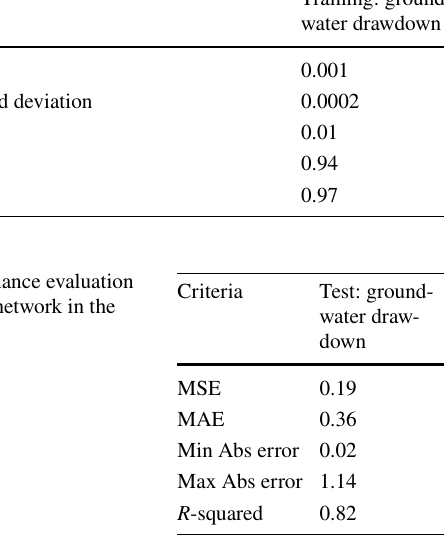
Table 3 Performance evaluation of the CANFIS network in the train- ing stage. In the cross-validation stage, MSE and standard deviation (SD) were 0.009 and 0.0007, respectively